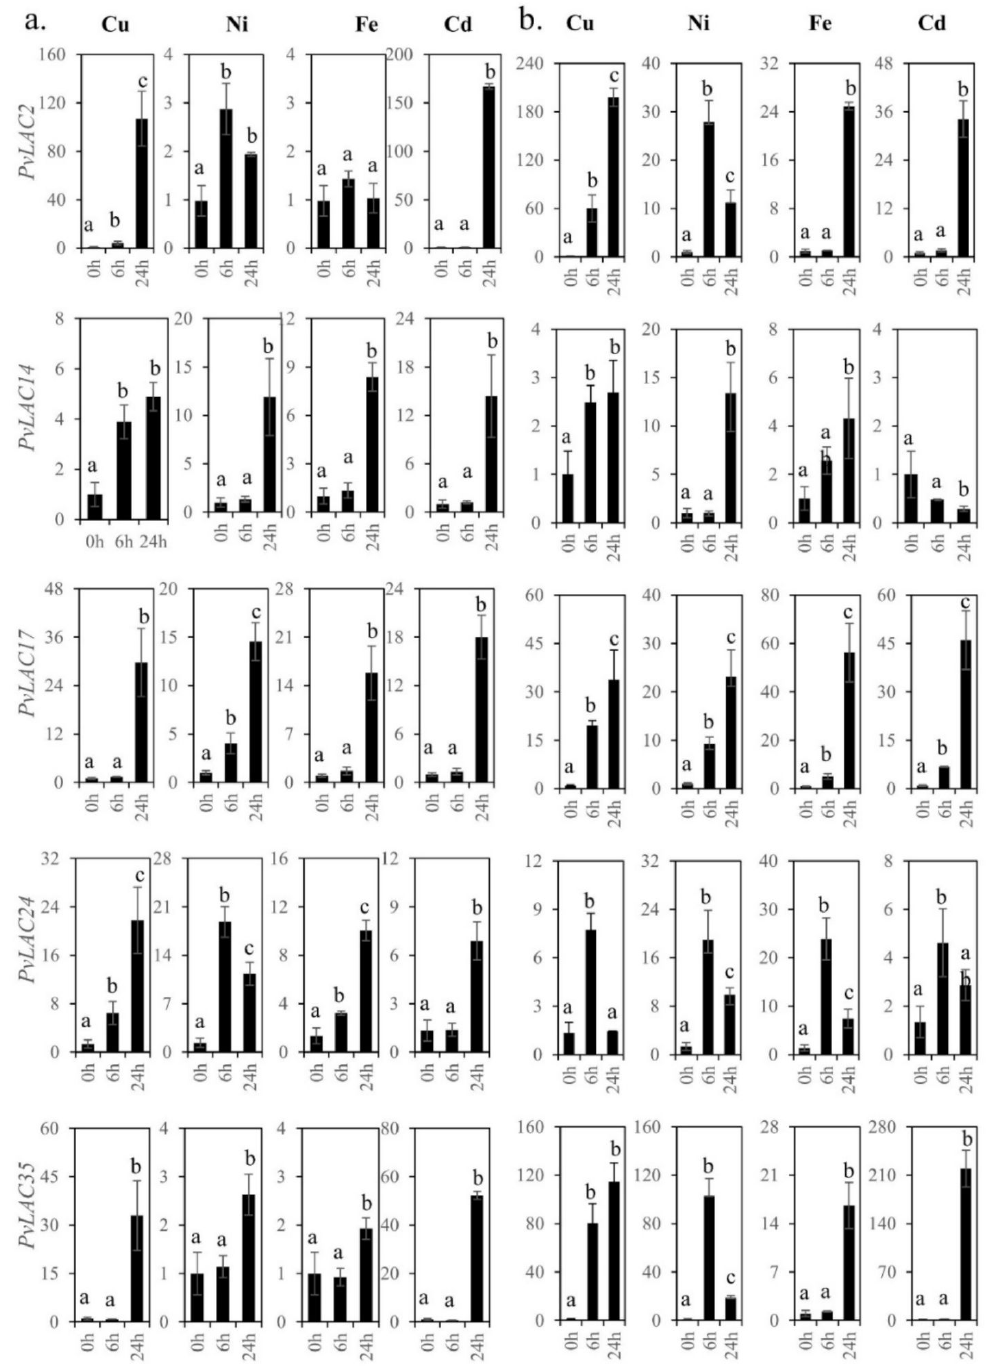
Figure 6. Response of PvLac s to heavy-metal treatment at concentrations of ( a ) 100 µ M and ( b ) 500 µ M. Significant differences are indicated by different letters (a, b, and c) after ANOVA analysis ( p < 0.05). Error bars represent SD (n =